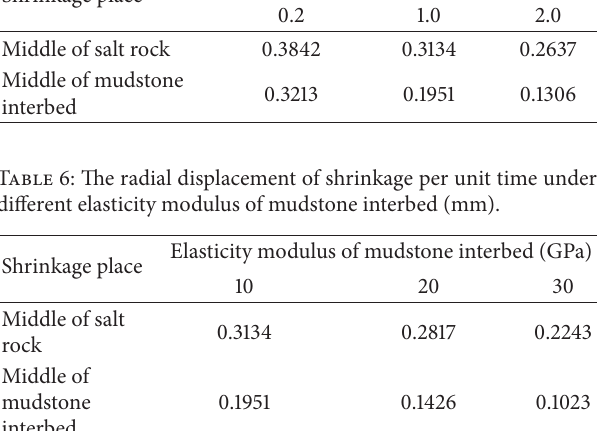
Figure 2: Mesh graph of XOZ plane.